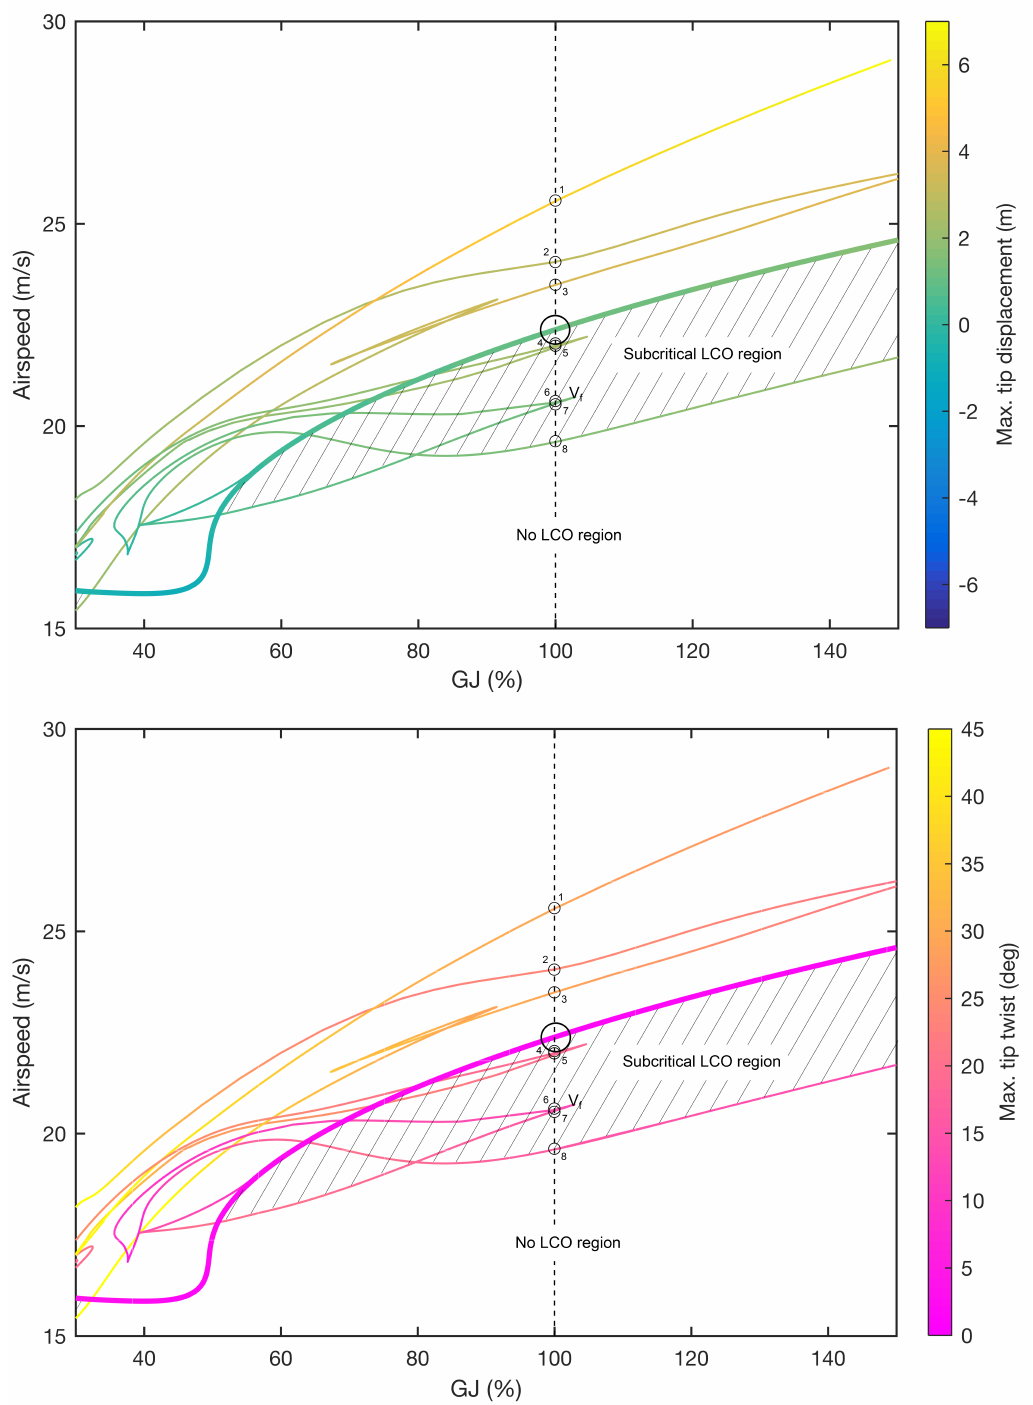
Figure 14. Two-parameter continuation of Hopf points and periodic folds for varying torsional stiffness and airspeed. The shaded region indicates where subcritical LCOs exist in the system.